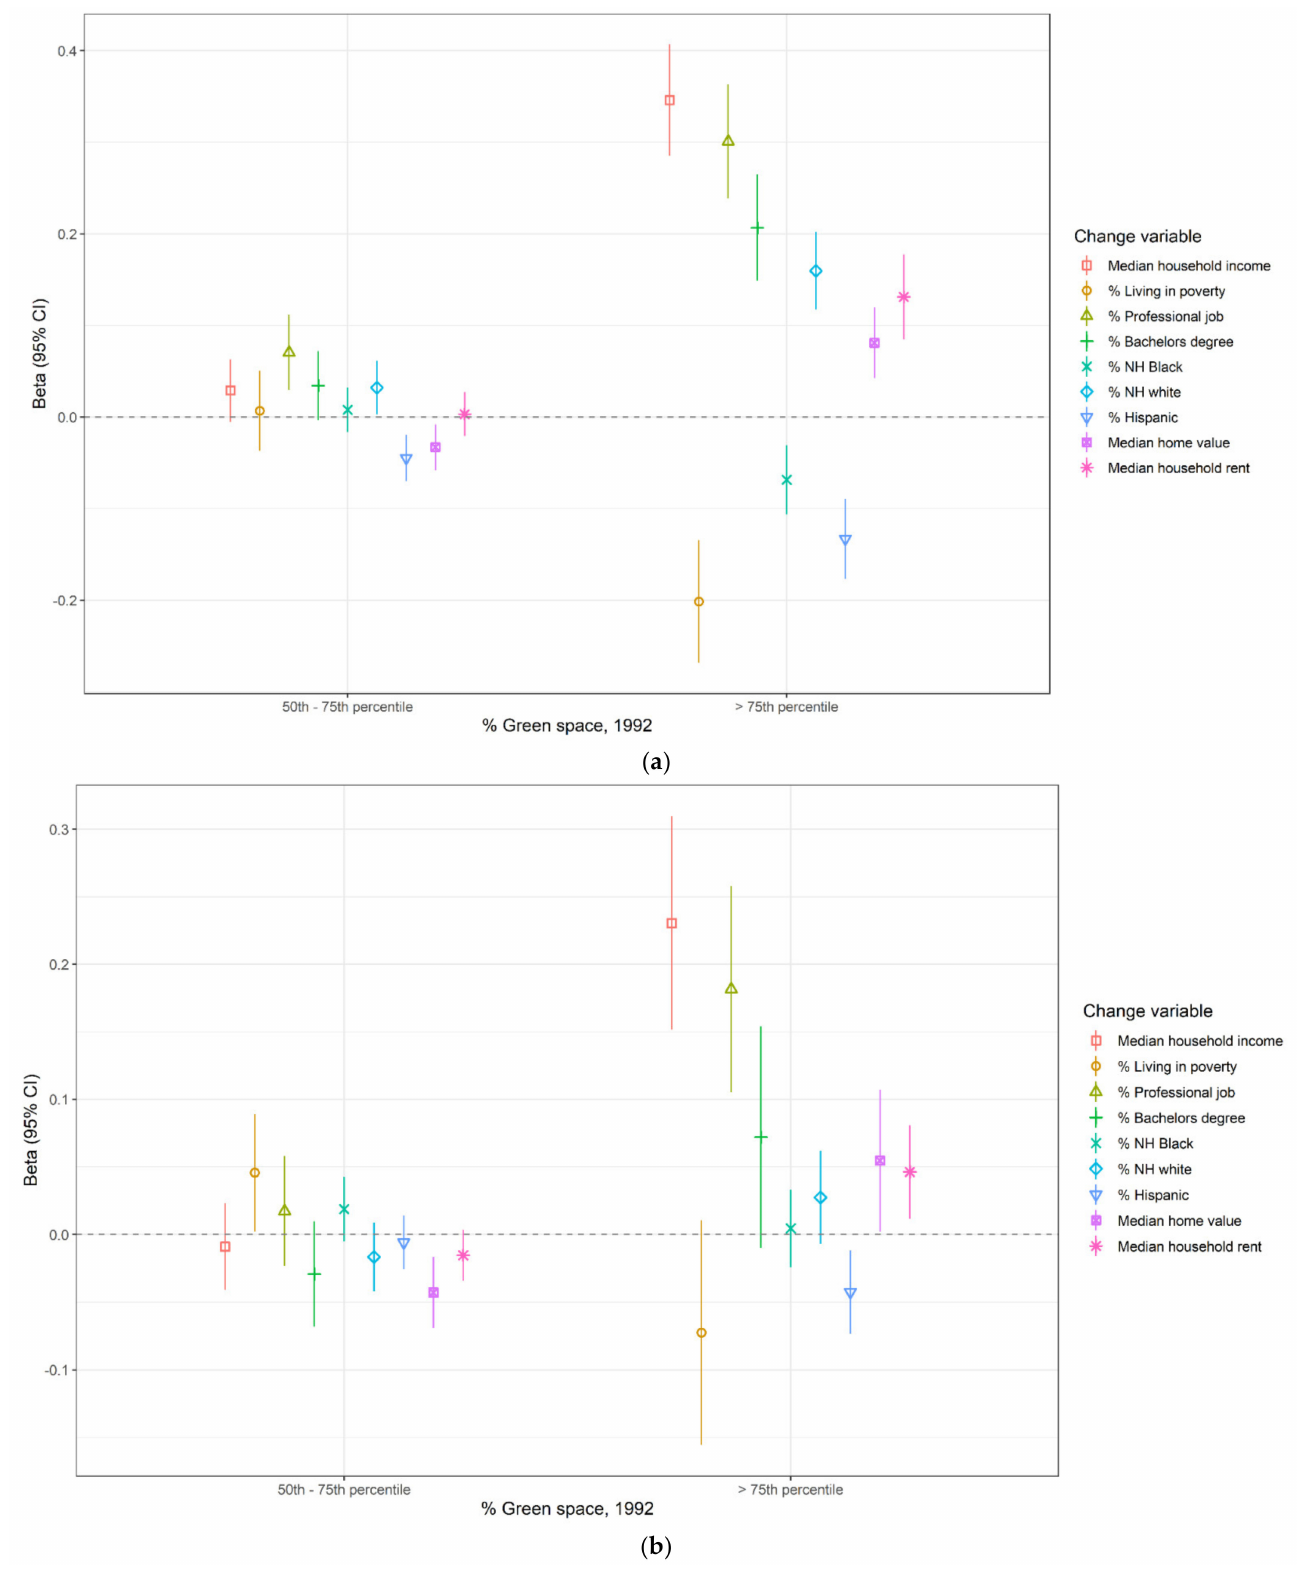
Figure 1. Meta-analytic estimates of association between percentage greenspace in 1992 and sociodemographic and housing cost changes in 1990–2000, among gentrifiable census tracts in the 43 largest MSAs in the United States: ( a ) unadjusted; ( b ) adjusted for population density in